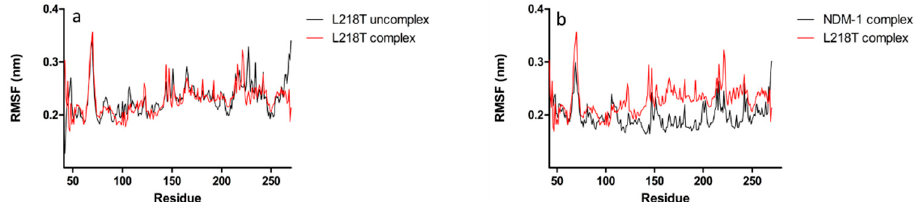
Figure 5. Evaluation of NDM-1 and L218T mutant flexibility related to meropenem interaction through comparison of root-mean-square fluctuations per residue. Flexibility pattern of ( a ) L218T mutant with (in red) and without (in black) meropenem, ( b ) NDM-1 (in black) and L218T mutant (in red) with meropenem.